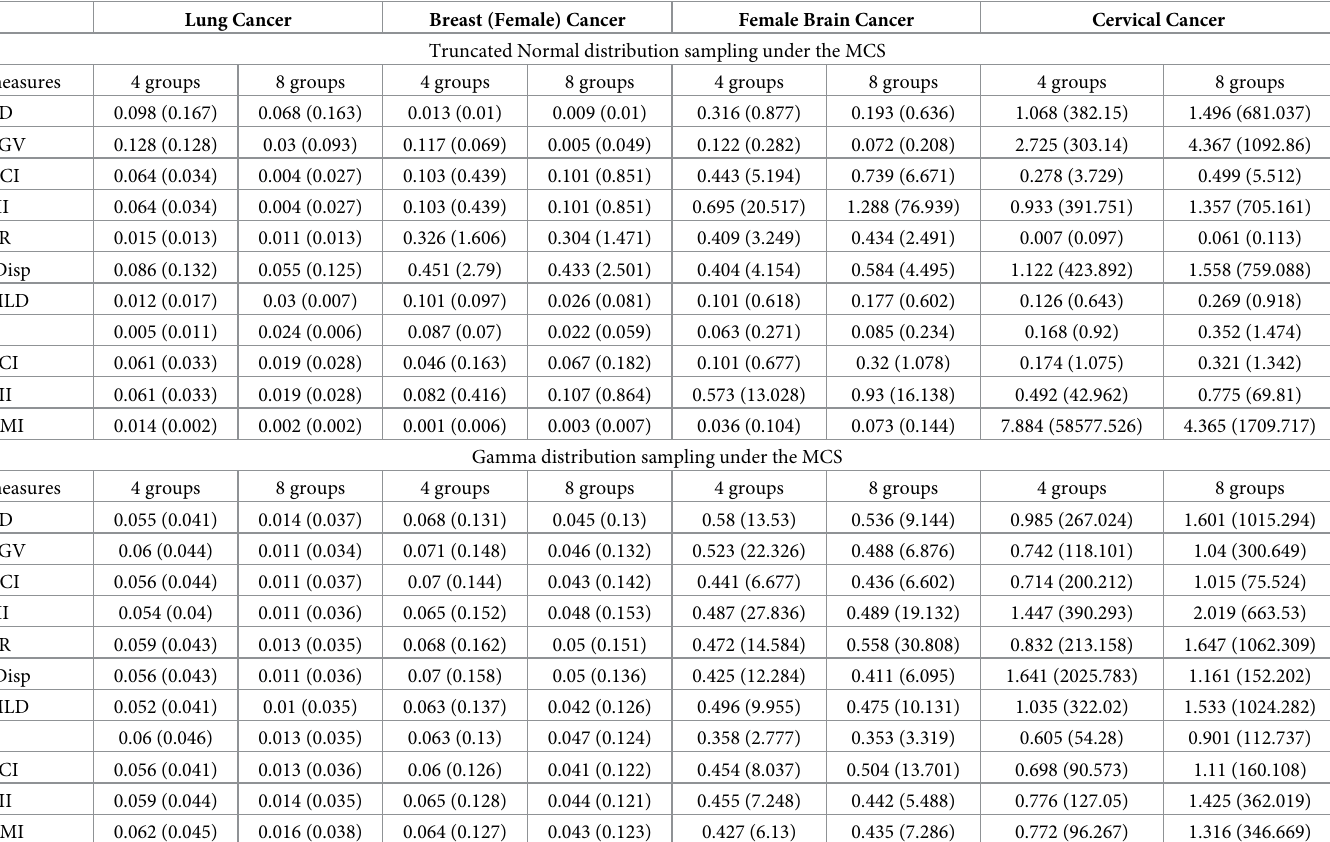
Table 3. The averaged relative changes (mean squared errors) are shown by four cancer types and the number of age-groups using the truncated normal distribution (top) and the gamma distribution (bottom) under the MCS. Lung Cancer Breast (Female)